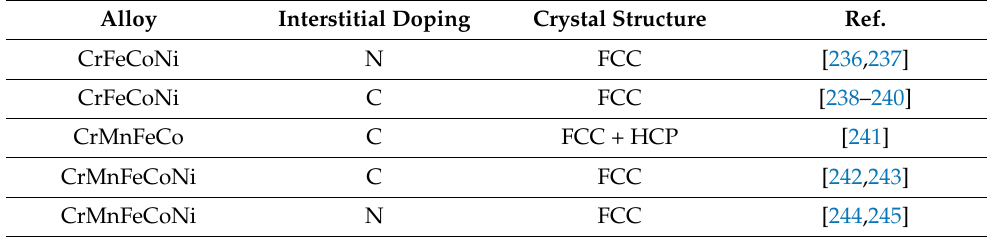
Table 10. Interstitial doping of HEAs fabricated by L-PBF process and pre-alloyed feedstock material. Alloy Interstitial Doping Crystal Structure